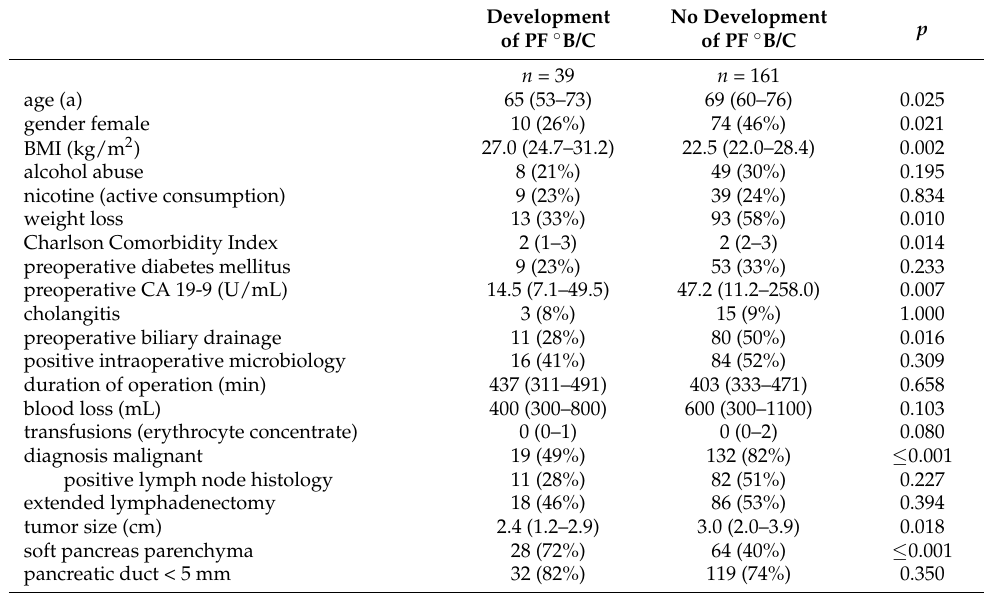
Table 1. Clinically relevant PF ◦ B/C—demographic and perioperative data.